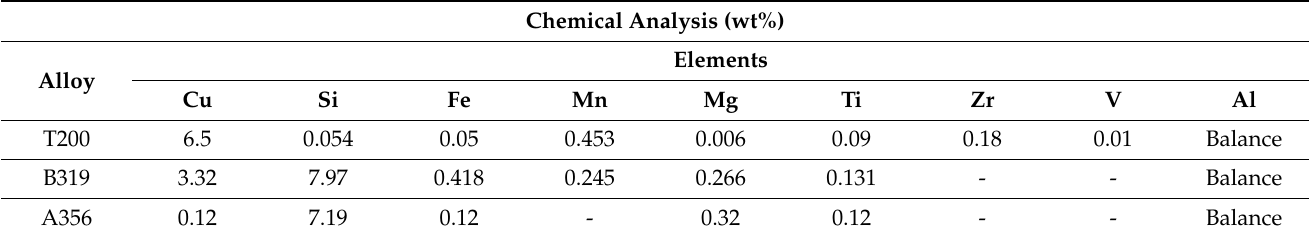
Table 1. Chemical composition of the as-received alloys for the present work. Chemical Analysis (wt%)